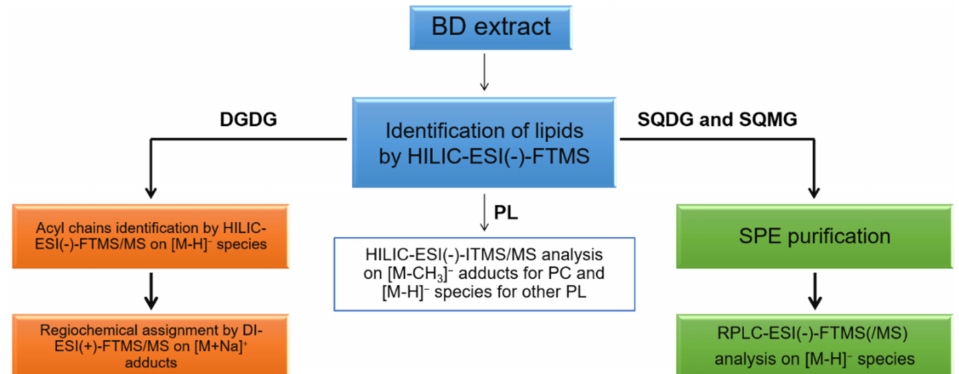
Figure 1. Adopted workflow: lipids from algal samples were extracted by using the procedure described by Bligh and Dyer. HILIC-ESI-(-)-FTMS(/MS) and HILIC-ESI-(-)-ITMS/MS were employed, in synergy, to characterize PL and DGDG; the regiochemistry of DGDG was assessed using direct infusion (DI)-ESI(+)-FTMS/MS analyses on the corresponding sodium adducts. RPLC-ESI(-)-FTMS/MS, following SPE-based purification, was adopted for the characterization of sulfur-containing glycolipids SQDG and